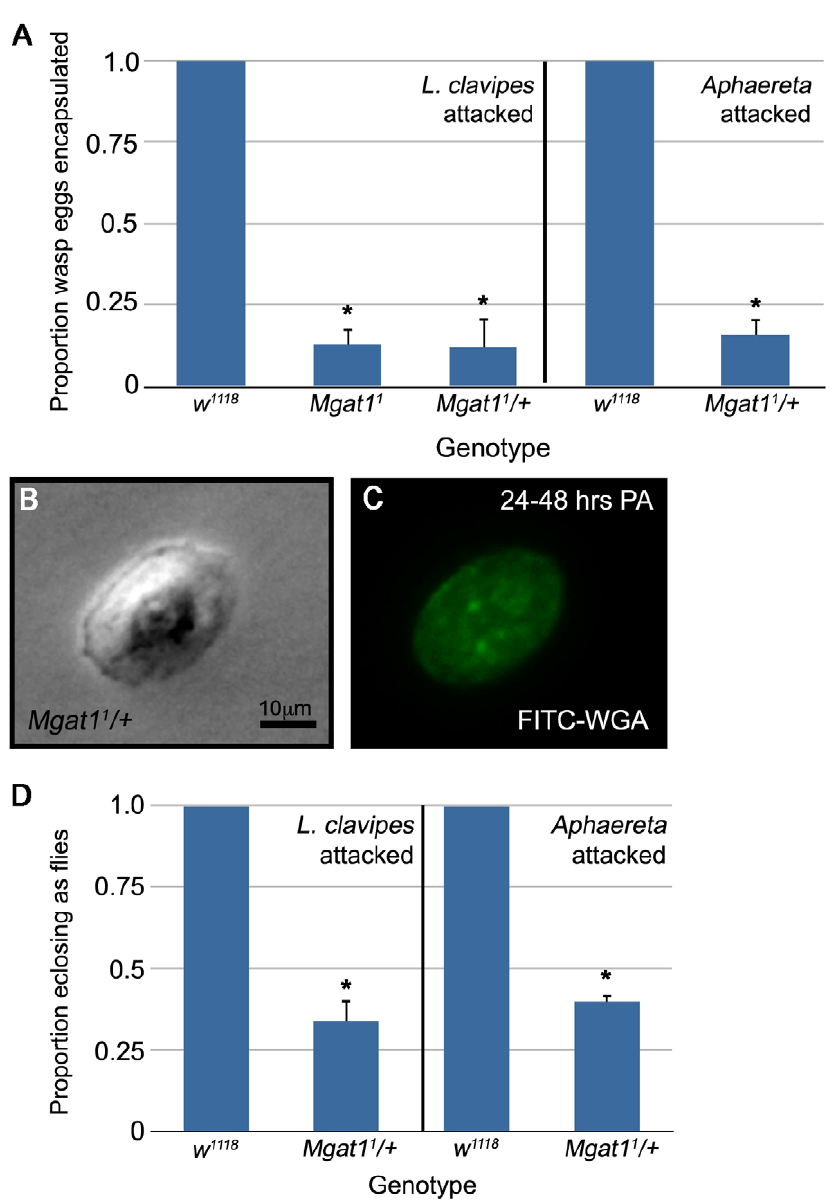
Figure 3. Mgat1 is required for wasp egg encapsulation. (A) Proportion of wasp eggs encapsulated in the indicated genotypes. Mgat1 appears haploinsufficient for encapsulation of both L. clavipes (left) and Aphaereta sp. (right) eggs. (B,C) Paired brightfield and FITC images of hemocytes stained with FITC-WGA. Lamellocytes from L. clavipes attacked Mgat1 1 / + larvae show intermediate levels of WGA staining at 24–48 hours PA. Scale bar indicates 10 m m. (D) Proportion of wasp exposed larvae of the indicated genotypes that eclosed as adult flies. The decreased encapsulation rate of Mgat1 1 / + larvae correlated with a decrease in fly eclosion. Error bars indicate standard error of the mean; * indicates p , 0.01 relative to control.